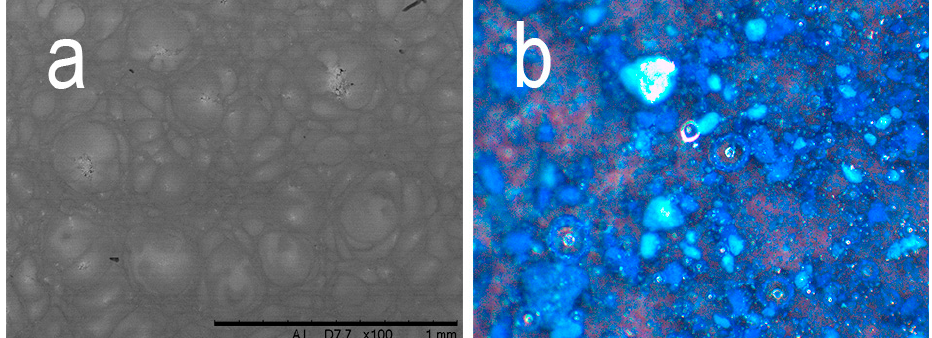
Figure 3. Images of the glaze prepared using CoGa 2 O 4 obtained by SEM (X 100) ( a ) and optical microscopy (X 60) ( b ).